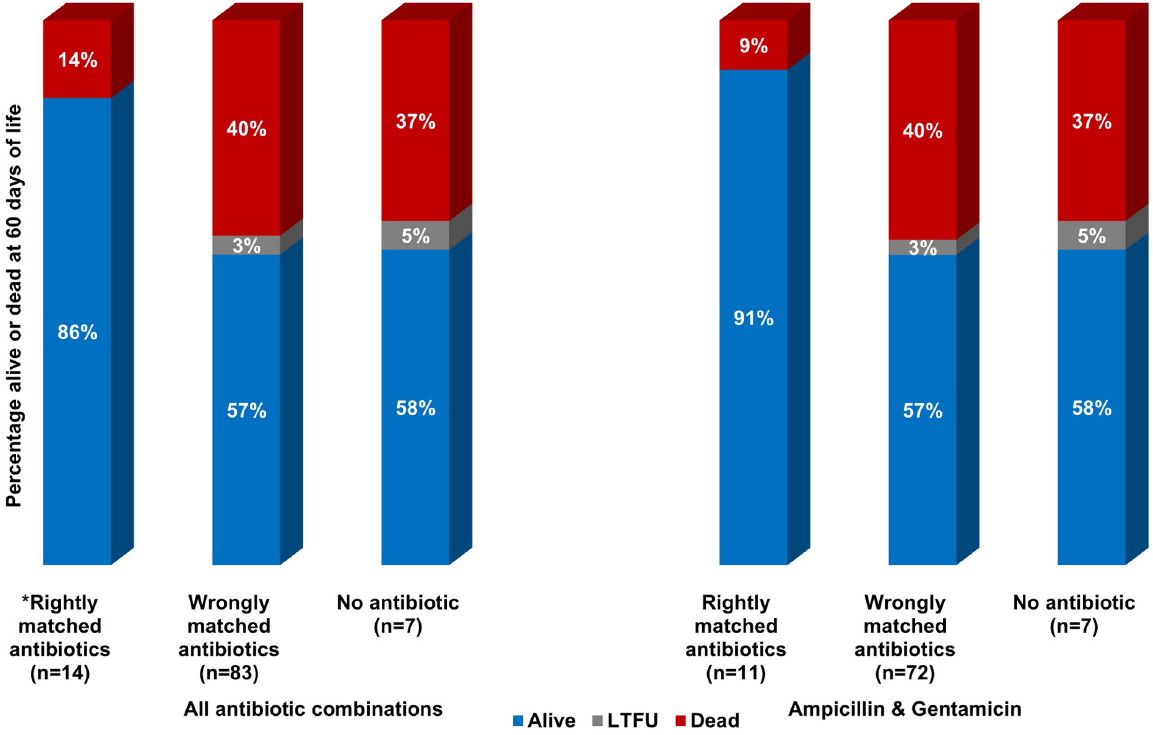
Fig 11. Newborn mortality at 60 days among term and preterm newborns by antibiotic choice (rightly matched, wrongly matched, no antibiotics). Among newborns who received antibiotics that were effective against their infections, there were two deaths (14%) out of 14 term newborns at 60 days, and 1 death (9%) out of 11 preterm newborns. Mortality at 60 days among term and preterm newborns who received antibiotics to which their infections were resistant was 40% and 37% among those who received no antibiotics. � Rightly matched antibiotics represent antibiotic combinations for which the phenotypes of identified gram-negative isolates were susceptible. Wrongly matched antibiotics represent antibiotic combinations for which the phenotypes of identified gram-negative isolates were resistant. No antibiotic refers to no evidence or documentation that any antibiotics were received. LTFU, lost to follow-up and vital status is